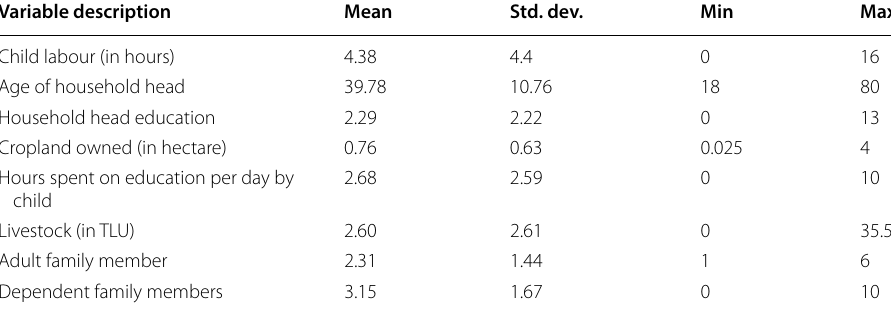
Table 2 Descriptive statistics of potential covariates. Source: Own Survey, 2015 Variable description Mean Std. dev.